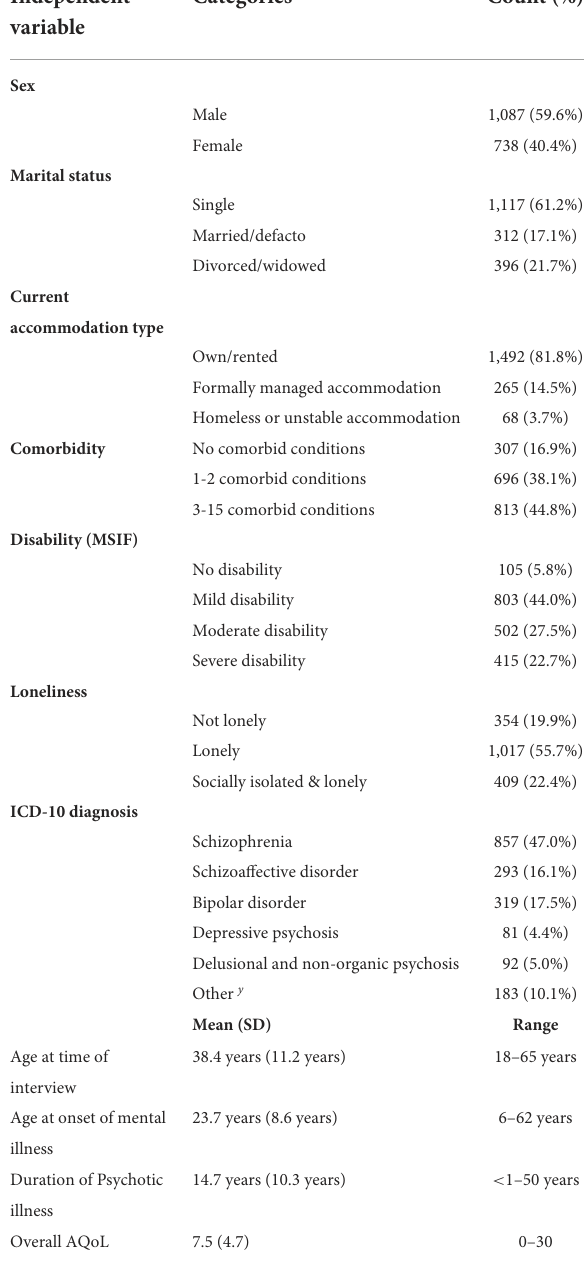
TABLE 1 Descriptive characteristics of the participant sample ( N =